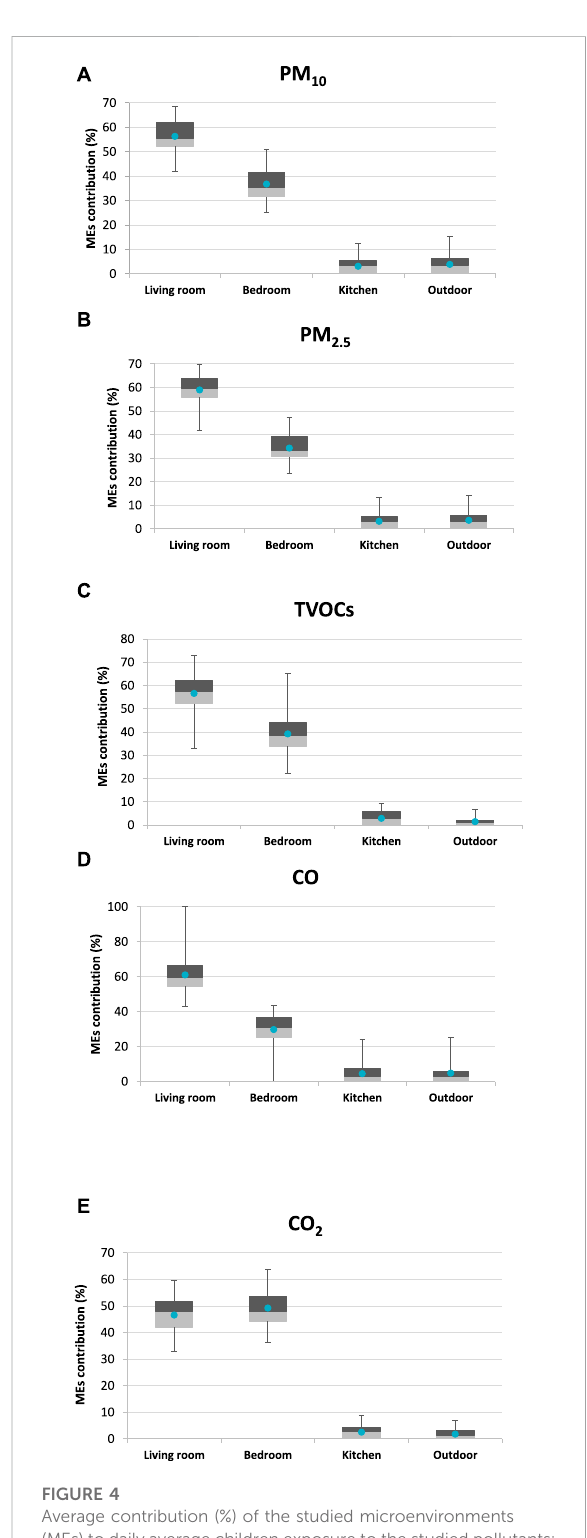
FIGURE 4 Average contribution (%) of the studied microenvironments (MEs) to daily average children exposure to the studied pollutants: (A) PM 10 , (B) PM 2.5 , (C) TVOCs, (D) CO, and (E) CO 2